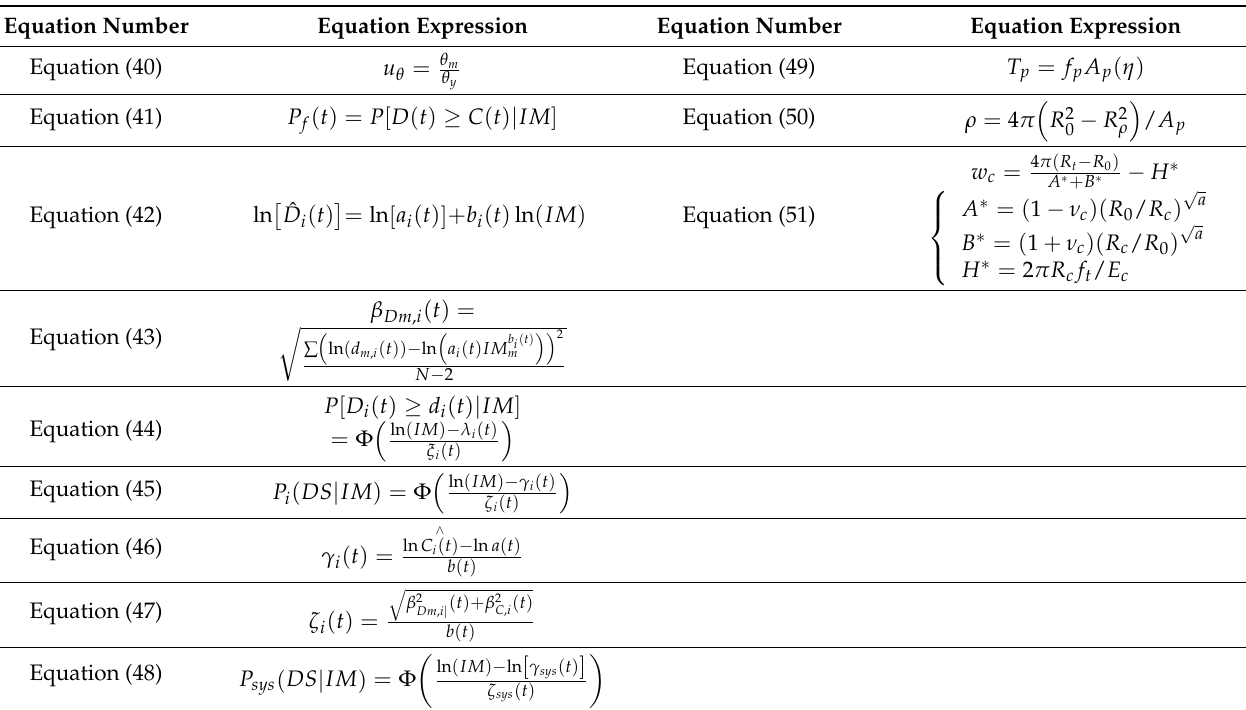
Table 5. Equation list for Sections 4 and